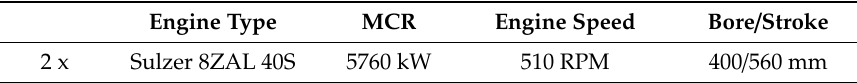
Table 3. Main engines specification.